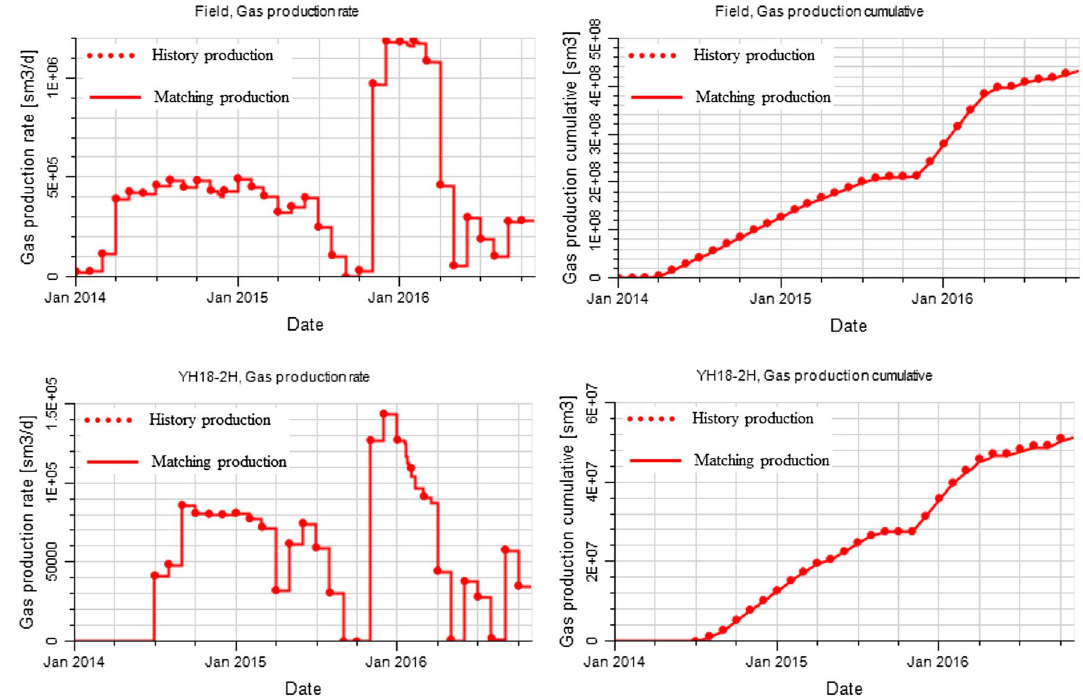
Fig. 5 Numerical simulation results of the sweet